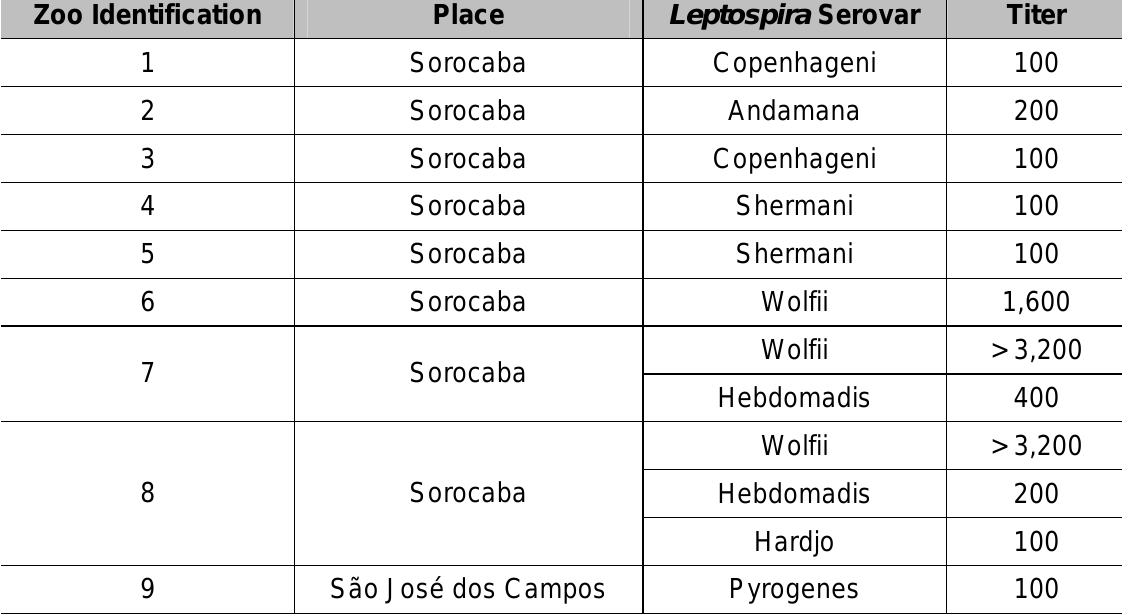
Table 1. MAT results for Leptospira spp. antibodies and respective titers in captive coati serum